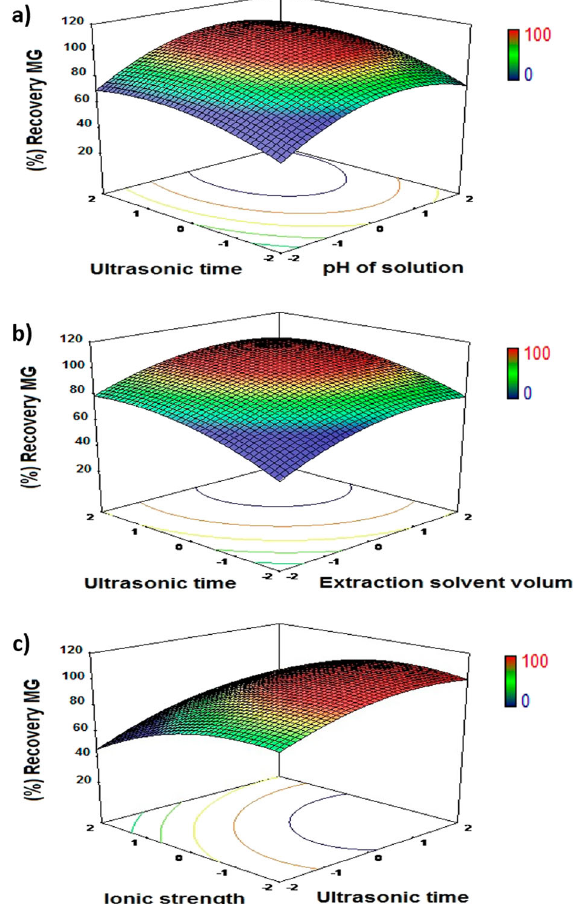
Fig. 6 The response surface plots showing the effects of variables on extraction of MG. a The interaction of ultrasonication time and pH of solution, b the interaction of ultrasonication time and extraction solvent volume, c the interaction of ionic strength and ultrasonication time (experimental conditions: ionic strength: 0.0 – 10.0 w/v%, extraction solvent: chloroform (50 – 250 µL), sonica- tion time: 1 – 5 min, dispersive solvent: ethanol (200 – 1000 µL), pH: 3 – 7, water sample volume: 10 mL, centrifuge rate: 3500 rpm, spiked concentration: 500 ng mL − 1